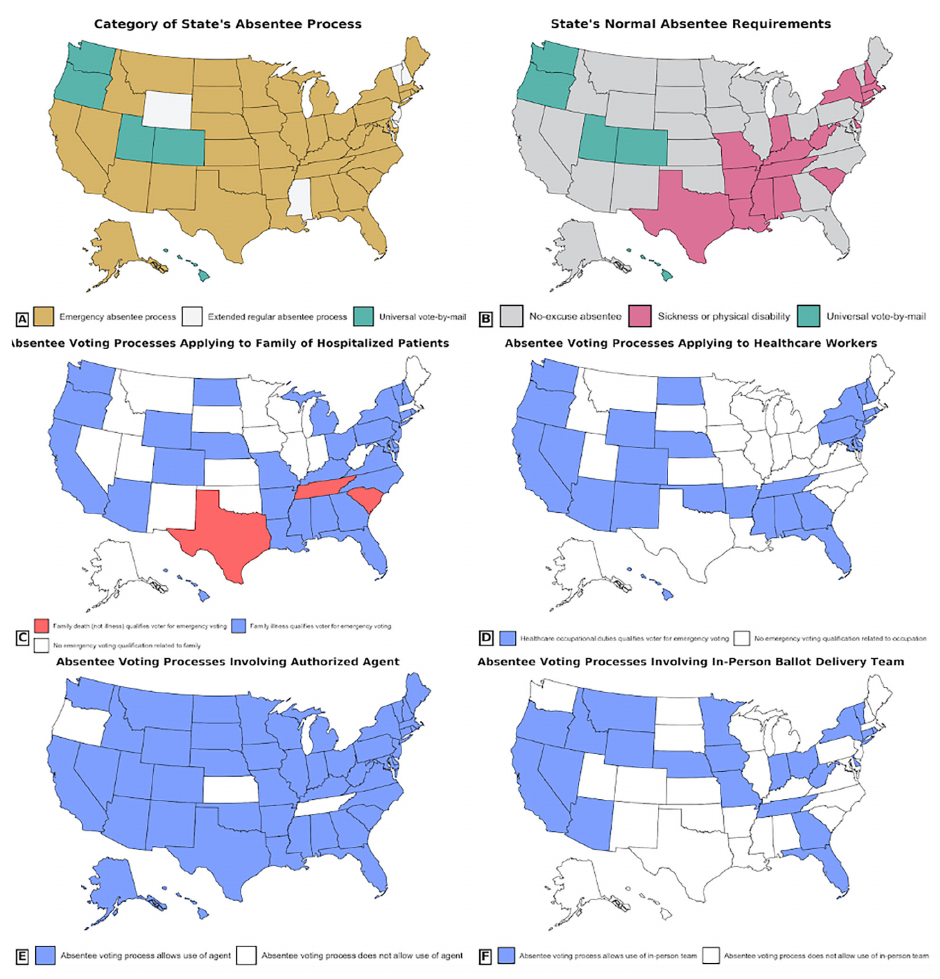
Figure 1. Nationwide map of state absentee voting practices. A. Nationwide distribution of absentee voting categories (universal vote- by-mail, no-excuse absentee voting, or absentee voting requiring an excuse). B. States with emergency absentee voting processes. C. States with absentee voting processes also applying to family members of hospitalized patients. D. States with absentee voting processes also applying to healthcare workers. E. States incorporating the use of an authorized agent for the voter. F. States using in- person ballot delivery